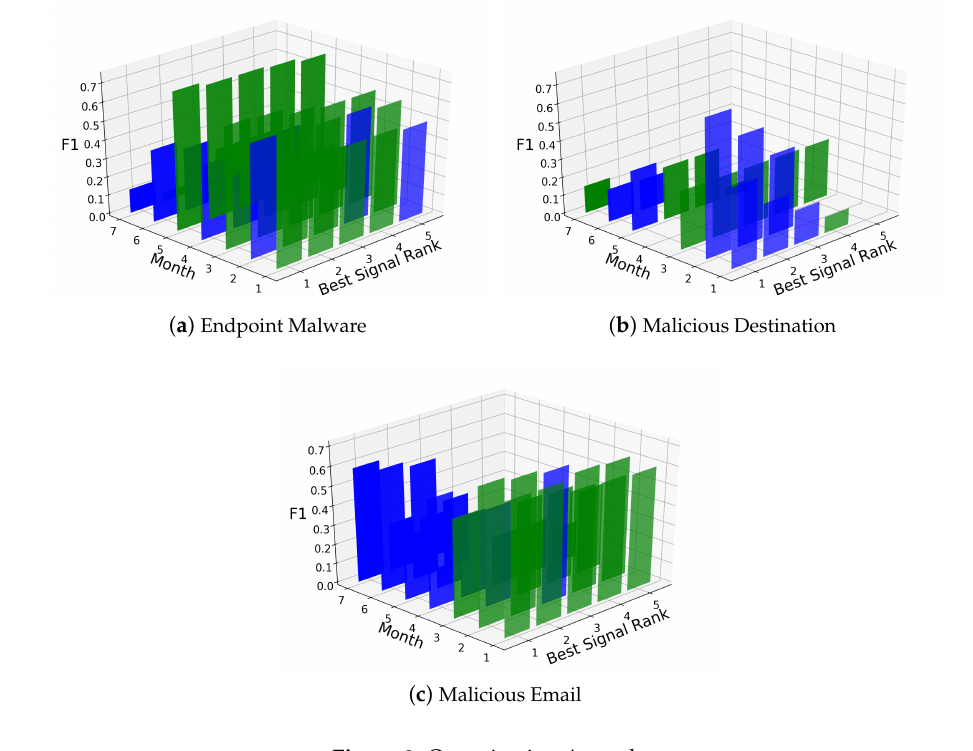
Figure 3. Organization A